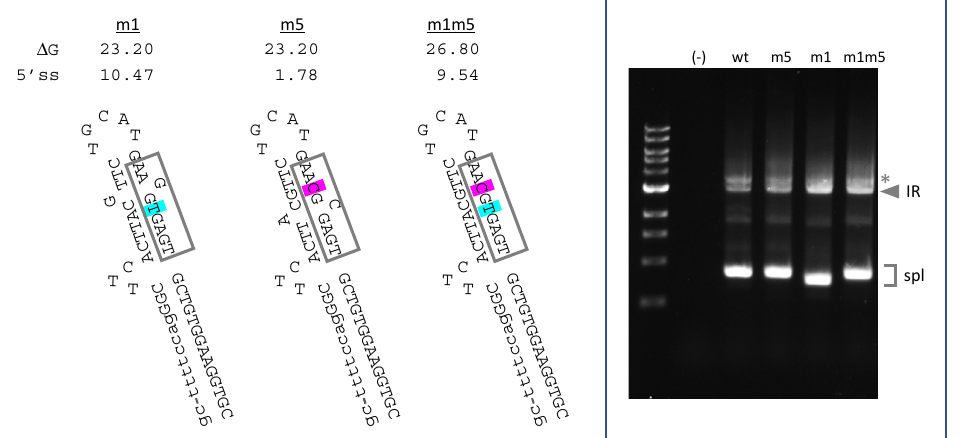
Figure 4. Effects of mutation m5 on IR predicted RNA structure and splice site strength ( left ) and splicing ( right ). For the gel analysis of splicing, lane (-) represents untransfected K562. Other lanes were transfected with VWFwt, VWFm5, VWFm1, and VWFm1m5 as indicated. * Indicates PCR artifact.